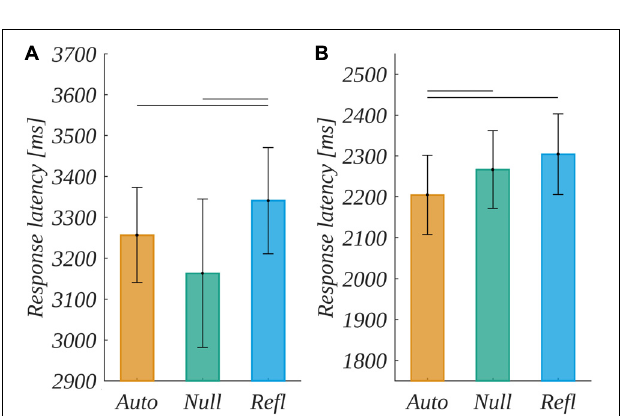
FIGURE 2 | The differences in latencies of deciding in ambiguous task in previous experiments, means for groups in milliseconds for Antosz and Imbir (2017) (A) , as well as for Imbir (2017) (B) . The bars and SEM are in linear scale, the statistical differences marked by horizontal lines were computed for logarithms of